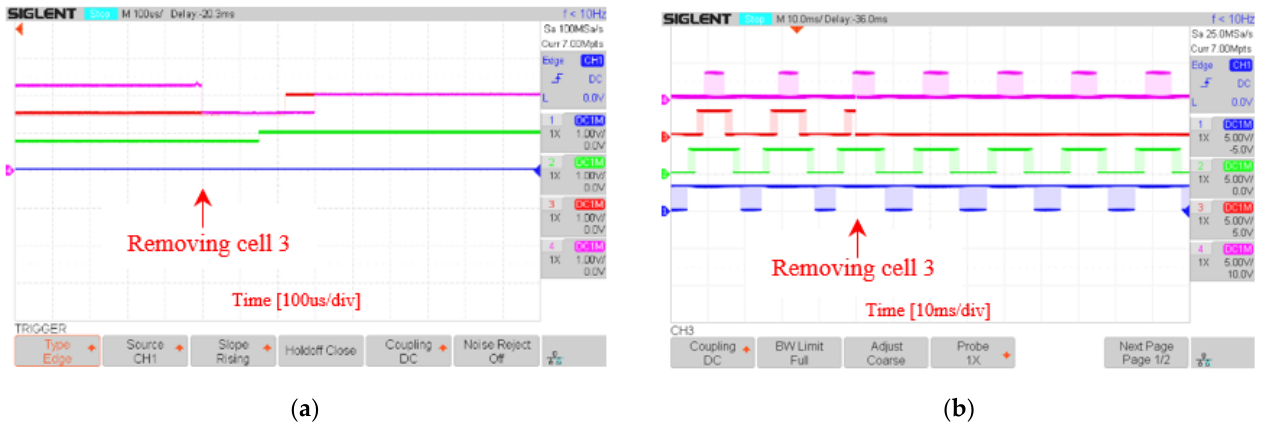
Figure 40. The system response of restructuring when removing cell 3 by using DSA-LSC method, ( a ) carrier levels; ( b ) PWM control signals.